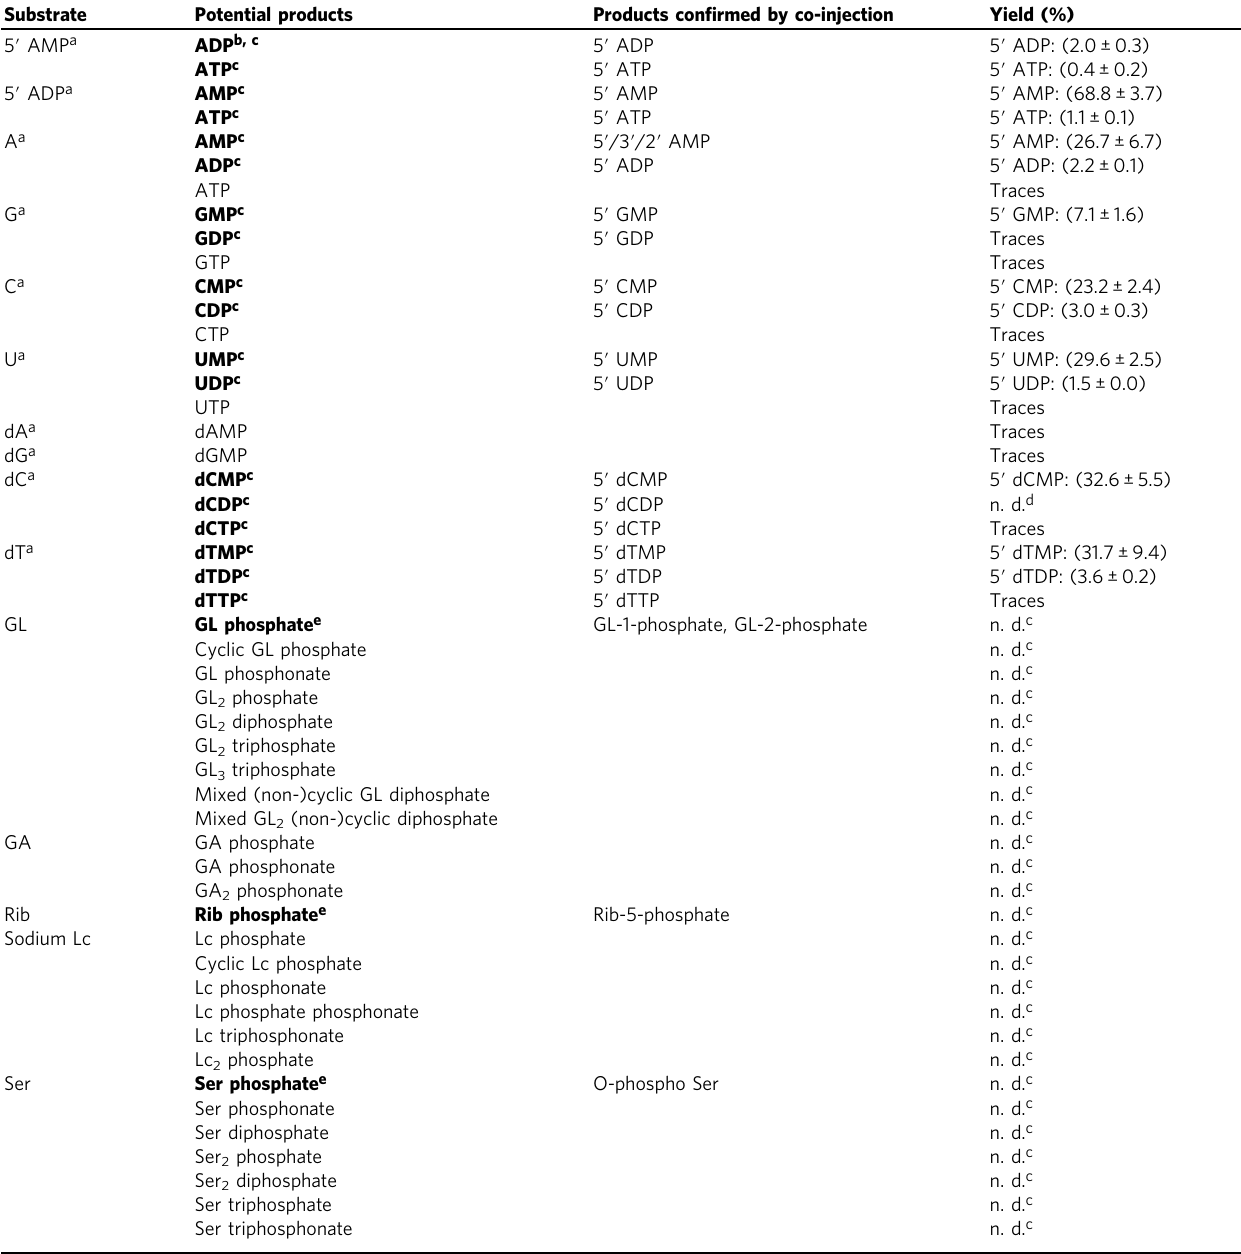
Table 1 Substrates investigated in the phosphorylation reaction. Substrate Potential